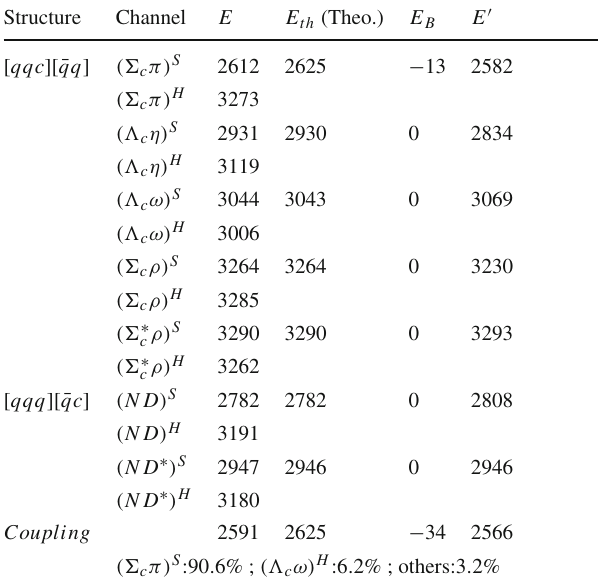
Table 5 The energies of the qqq ¯ qc pentaquark system with quantum − ) (unit: MeV) numbers I ( J P ) = 0 ( 1 2